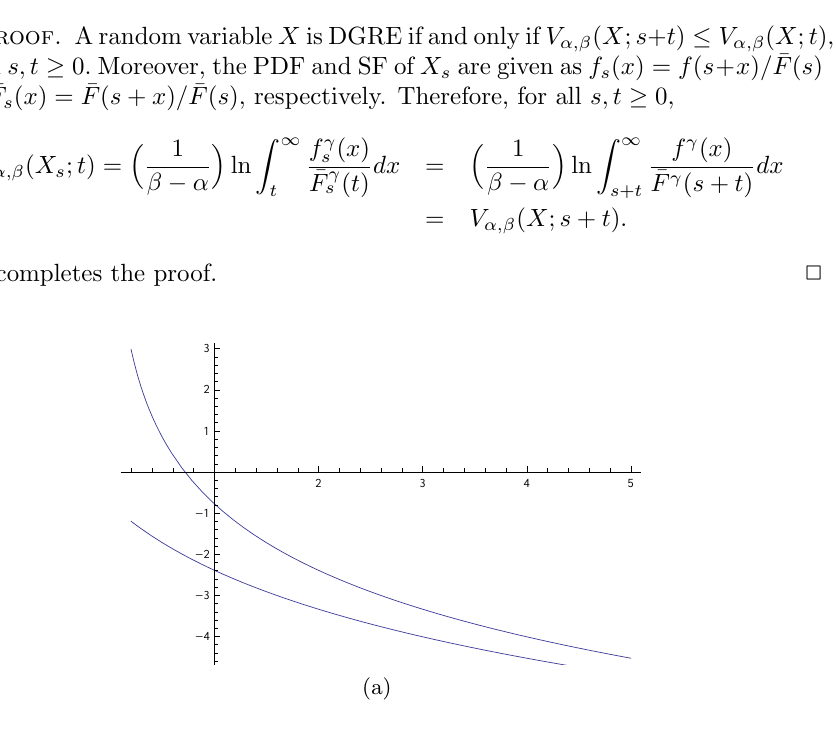
Figure 1 { Plot of V (cid:11);(cid:12) ( X ; s + t ) (bottom curve) and V (cid:11);(cid:12) ( X ; t ) (top curve) versus t (along horizontal axis) for Pareto distribution as described in Example 2 : Here we assume (cid:11) = 1 : 2 ; (cid:12) = 1 : 5 ; (cid:18) = 2 and s = 1